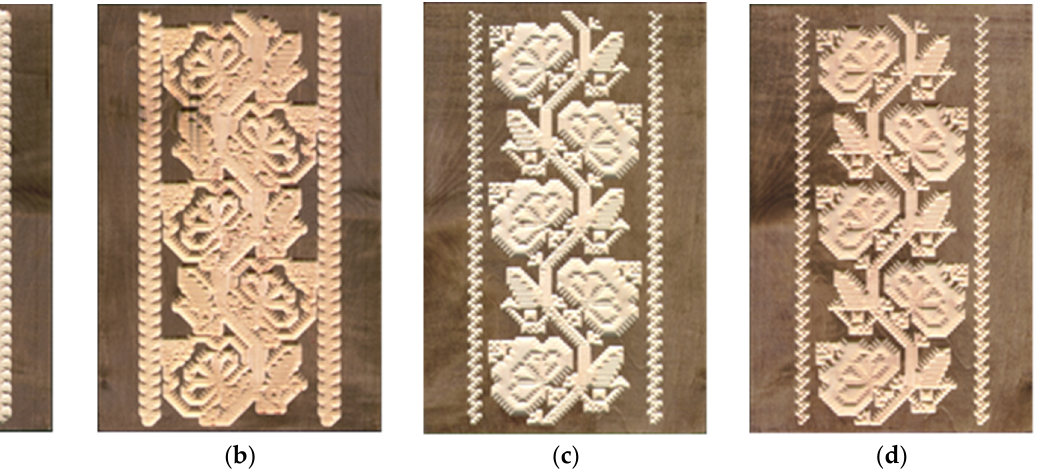
Figure 11. Coloring of the wood surface: ( a ) CNC engraved motif on colored maple wood; ( b ) lac- quered panel ( a ); ( c ) CNC V-carved motif on colored maple wood; ( d ) lacquered panel ( c ).